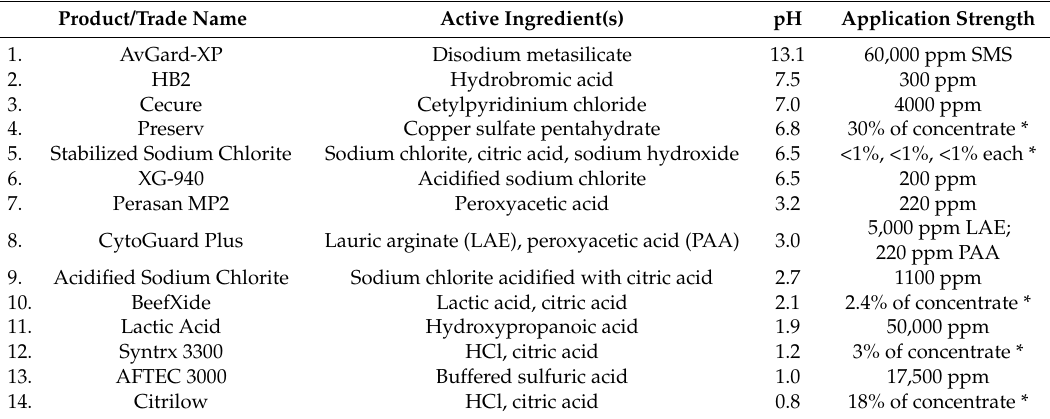
Table 1. List of antimicrobials used in Phase 1 (inoculated lean beef